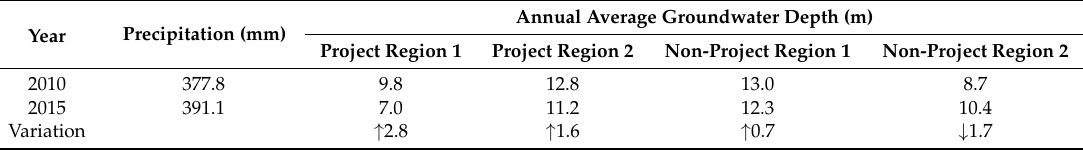
Table 5. The groundwater depth variation before and after treatment implemented in project regions and non-project regions (m).